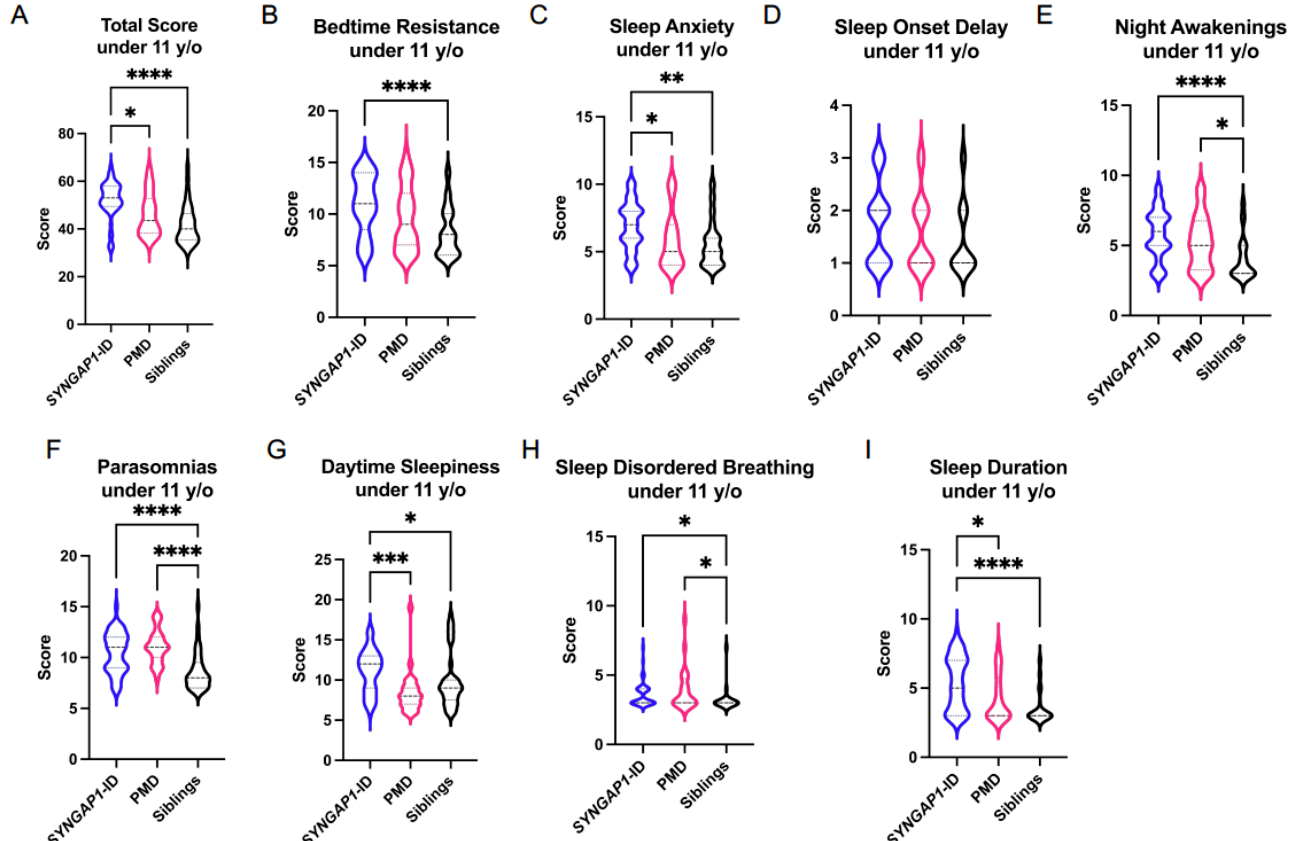
Figure 2. Total ( A ) and sub-scale scores for SYNGAP1 -related intellectual disability ( SYNGAP1 -ID), Phelan–McDermid syndrome (PMD) and unaffected siblings (Siblings) under 11 years of age. Sub-scales: ( B ) Bedtime Resistance, ( C ) Sleep Anxiety, ( D ) Sleep Onset Delay, ( E ) Night Awakenings, ( F ) Parasomnias, ( G ) Daytime Sleepiness, ( H ) Sleep Disordered Breathing, ( I ) Sleep Duration. Dunn’s multiple comparisons test * p < 0.05, ** p < 0.01, *** p < 0.001, **** p < 0.0001. Heavy dashed line is median, light dashed line is quartile.